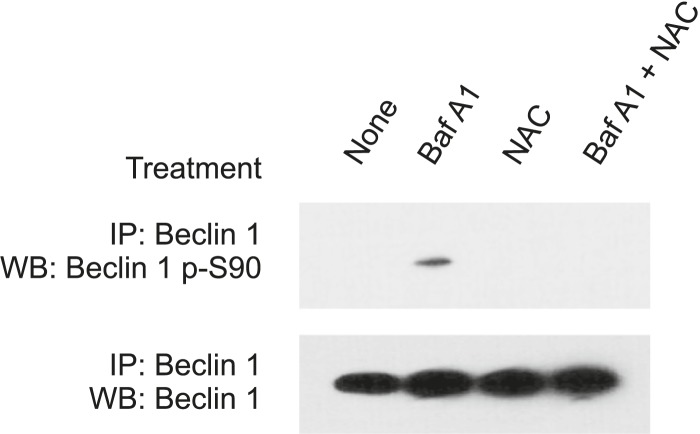
Bafilomycin A1-induced Beclin 1 S90 phosphorylation is reversed by the ROS scavenger, N-acetyl-L-cysteine.HeLa cells were either untreated, pre-treated or not pre-treated with 5 mM N-acetyl-L-cysteine for 1 hr, followed by culture either in the presence or absence 100 nM Bafilomycin A1 for 3 hr. Baf A1, bafilomycin A1; NAC, N-acetyl-L-cysteine.